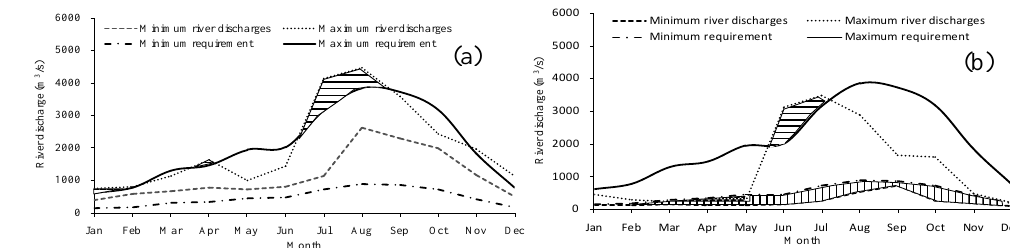
Fig. 7. Changes in monthly river discharge and the associated environmental flow boundary in the (a) 1950s and (b) 2000s.